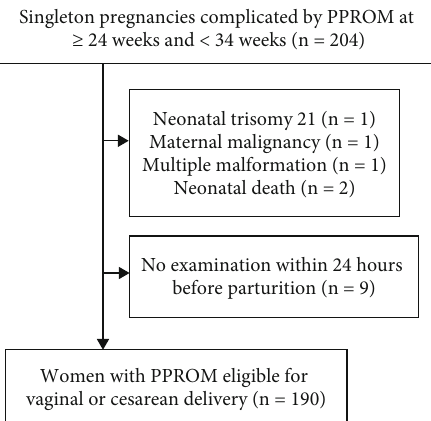
Figure 1: Flow chart of the included participants. PPROM: preterm premature rupture of